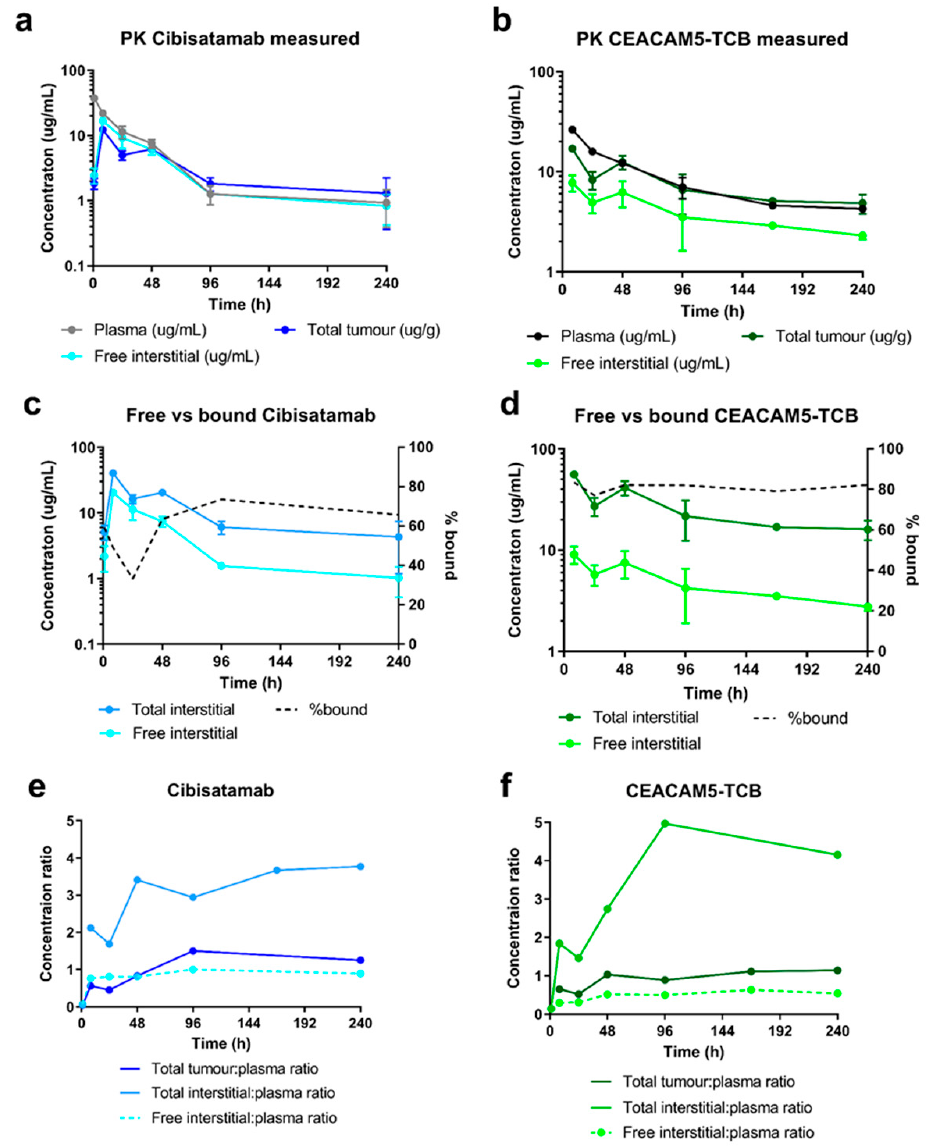
Figure 4. Measured or derived PK readouts based on the biodistribution study: plasma-, total tumour- and free interstitial PK profiles measured over 10 days after injection of a TCB dose of 2.5 mg/kg in the humanised NSG mice for ( a ) cibisatamab ( n = 18) and ( b ) CEACAM5-TCB ( n = 17), ( c ) measured free interstitial- compared to the derived total interstitial PK and the corresponding % of bound antibody for cibisatamab and ( d ) CEACAM5-TCB, ( e ) calculated total tumour: plasma- (dark), total interstitial: plasma (light) and free interstitial: plasma (dashed) concentration ratio for cibisatamab (blue) and ( f ) CEACAM5-TCB (green). At each time point three mice of each treatment group were terminated and measured and data are presented as mean ± SD.